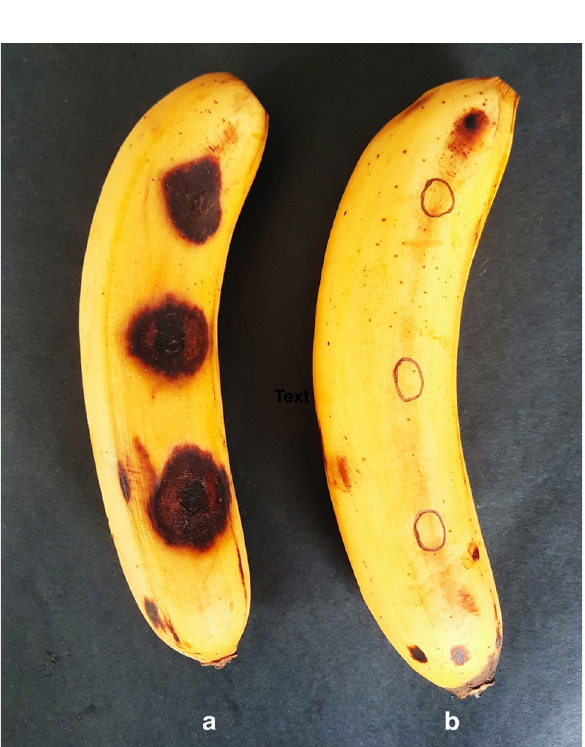
Figure 6. Banana fruit treated with ( a ) C. musae suspension and ( b ) CWE, after seven